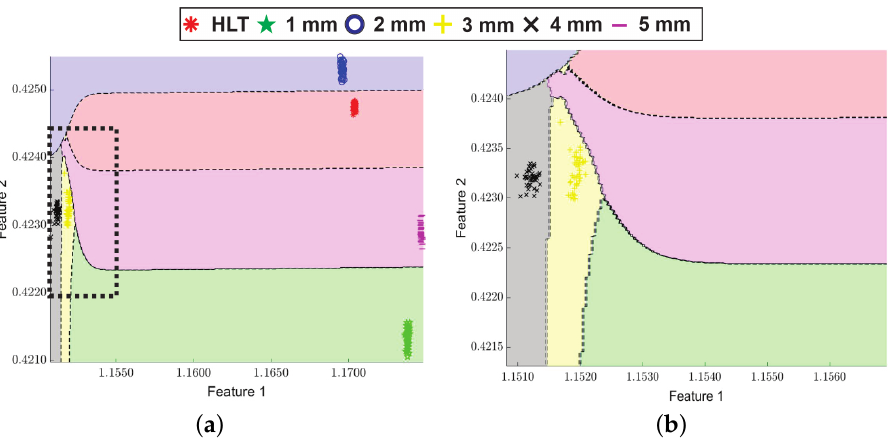
Figure 12. Projection of the decision regions for the multiple fault classification computed by the proposed FFNN-based classifier when the induction motor is driven at 50 Hz by using a VFD: ( a ) Complete view of the projection. ( b ) Zoomed view of the black rectangle